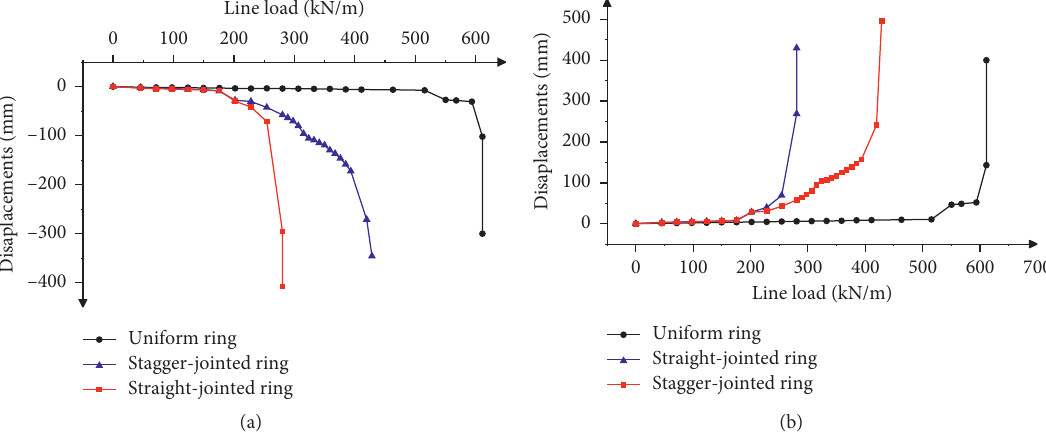
Figure 14: Variation of diameters of the target ring with the increase of the concentrated load. (a) Vertical diameters. (b) Horizontal diameters.